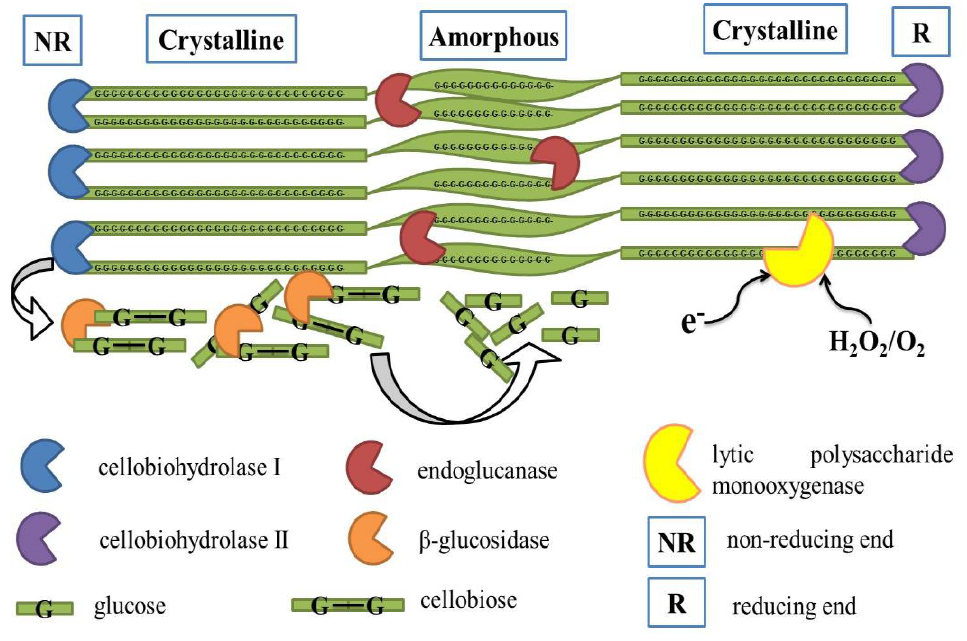
Figure 2. Mode of action of different cellulolytic enzymes for the hydrolysis of cellulose.